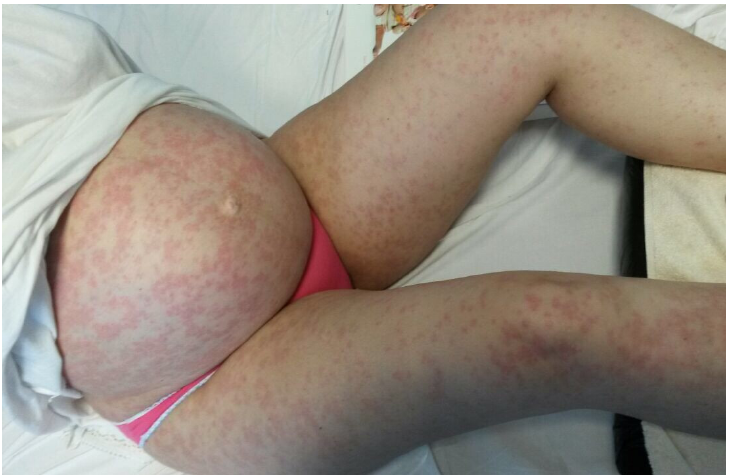
Figure 1. A monomorphic rash consisting of erythematous papules and round oval plaques dissem- inated on the abdomen and lower limbs, that spares the umbilicus.